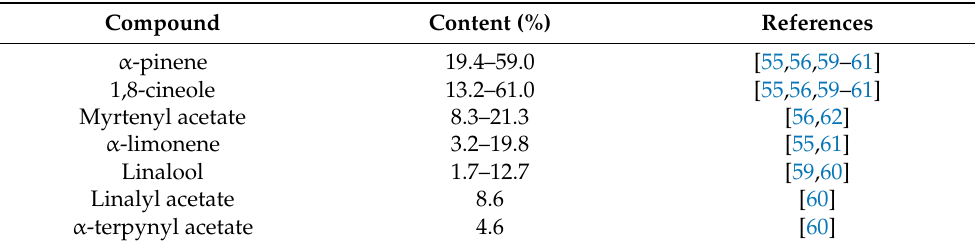
Table 3. The main compounds of the oil are distilled from the M. communis leaves.